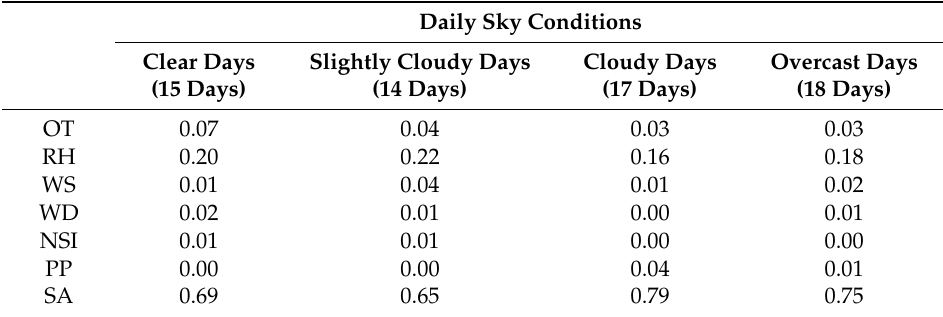
Table 3. The variable importance score of weather variables based on